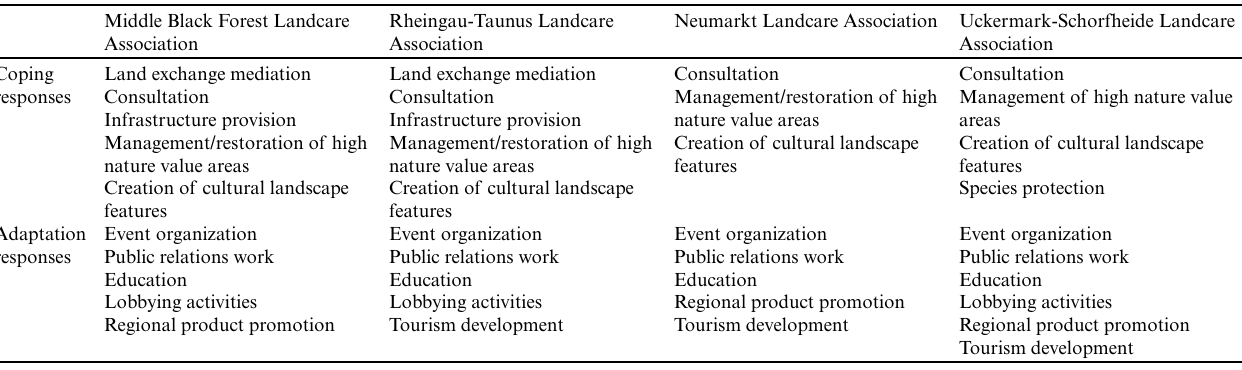
Table 3. Responses of the Middle Black Forest, Rheingau-Taunus, Neumarkt, and Uckermark-Schorfheide landcare associations to disturbances related to cultural landscape loss Middle Black Forest Landcare Rheingau-Taunus Landcare Neumarkt Landcare Association Uckermark-Schorfheide Landcare Association Association